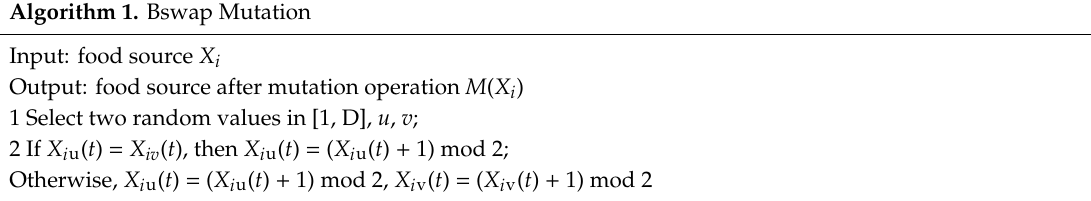
Algorithm 1. Bswap